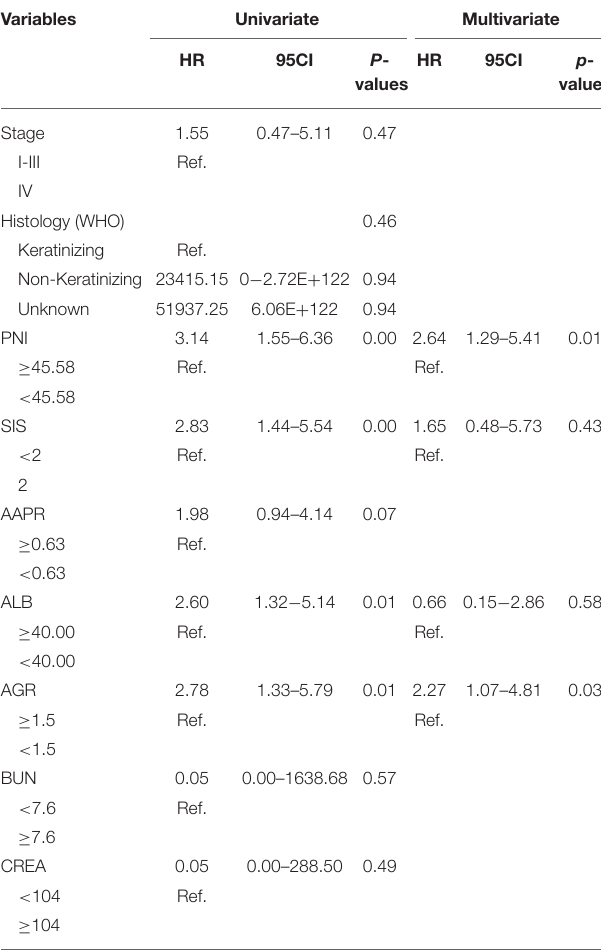
TABLE 3 | Univariate and multivariate Cox proportional hazards regression analysis for OS. Variables